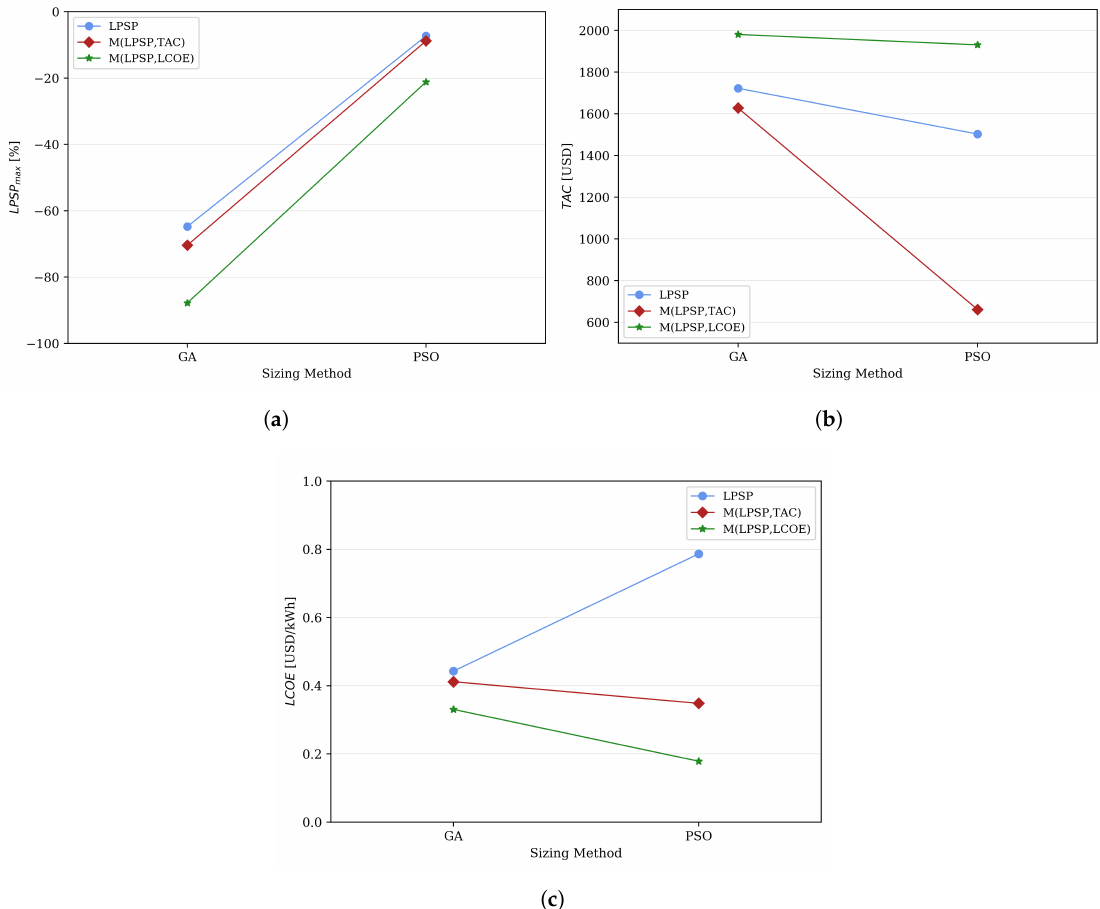
Figure 4. Interaction factors for Case I: demand of non-interconnected zone demand. ( a ) LPSP max ( b ) TAC ( c )